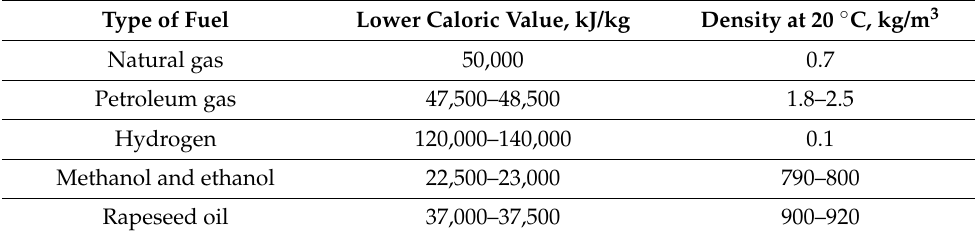
Table 1. Some characteristics of alternative